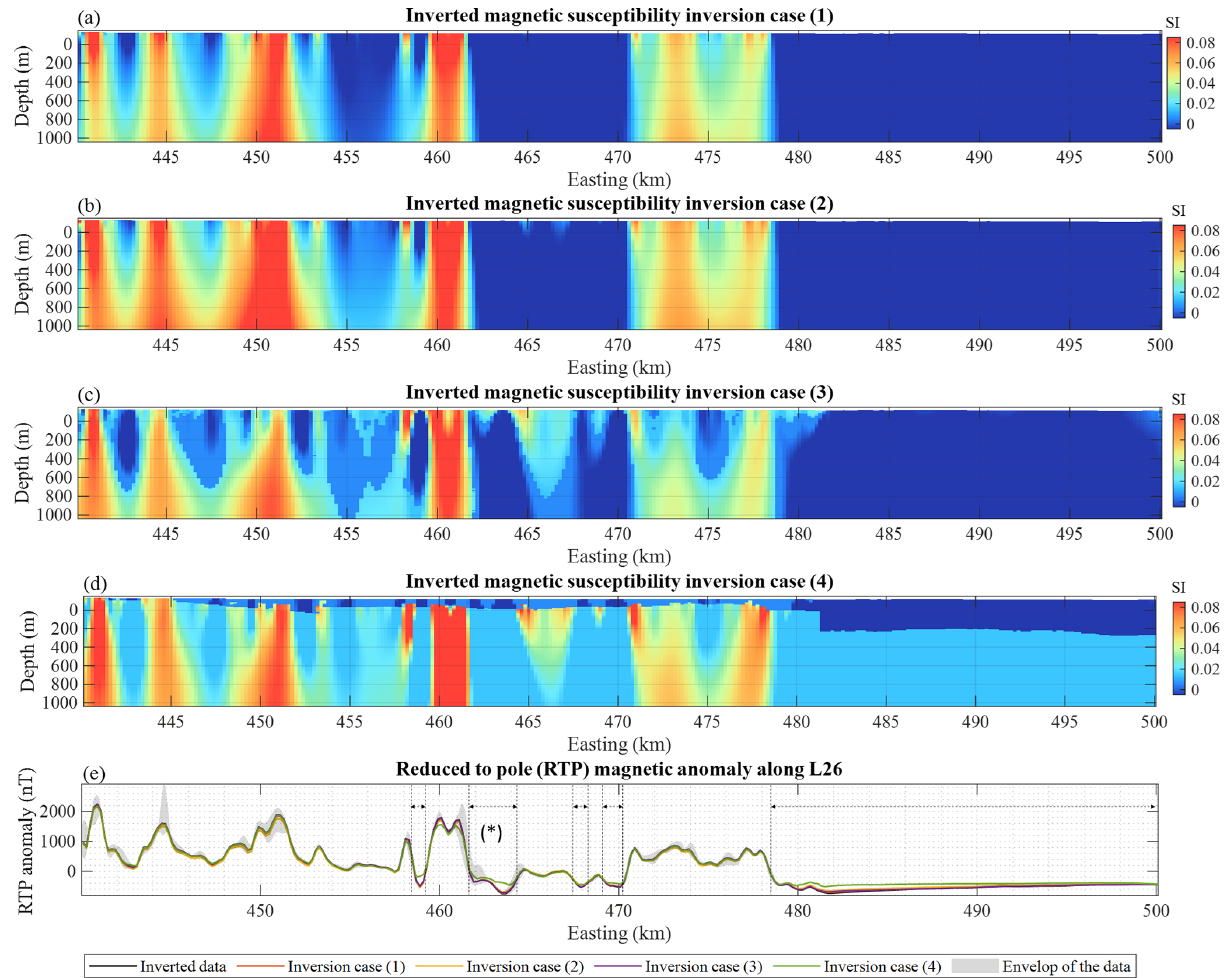
Figure 11. Inversion results. Panels (a) through (d) correspond to inversion types (1) through (4) as per Table 4, respectively; panel (e) shows the data fit for the four inversions shown. The grey shading shows the amplitude of the data shown in Fig. 9 for calculating the weighted average of the inverted anomaly. The dashed lines mark the horizontal extension of areas where hypotheses made for magnetic inversion may be incompatible with the